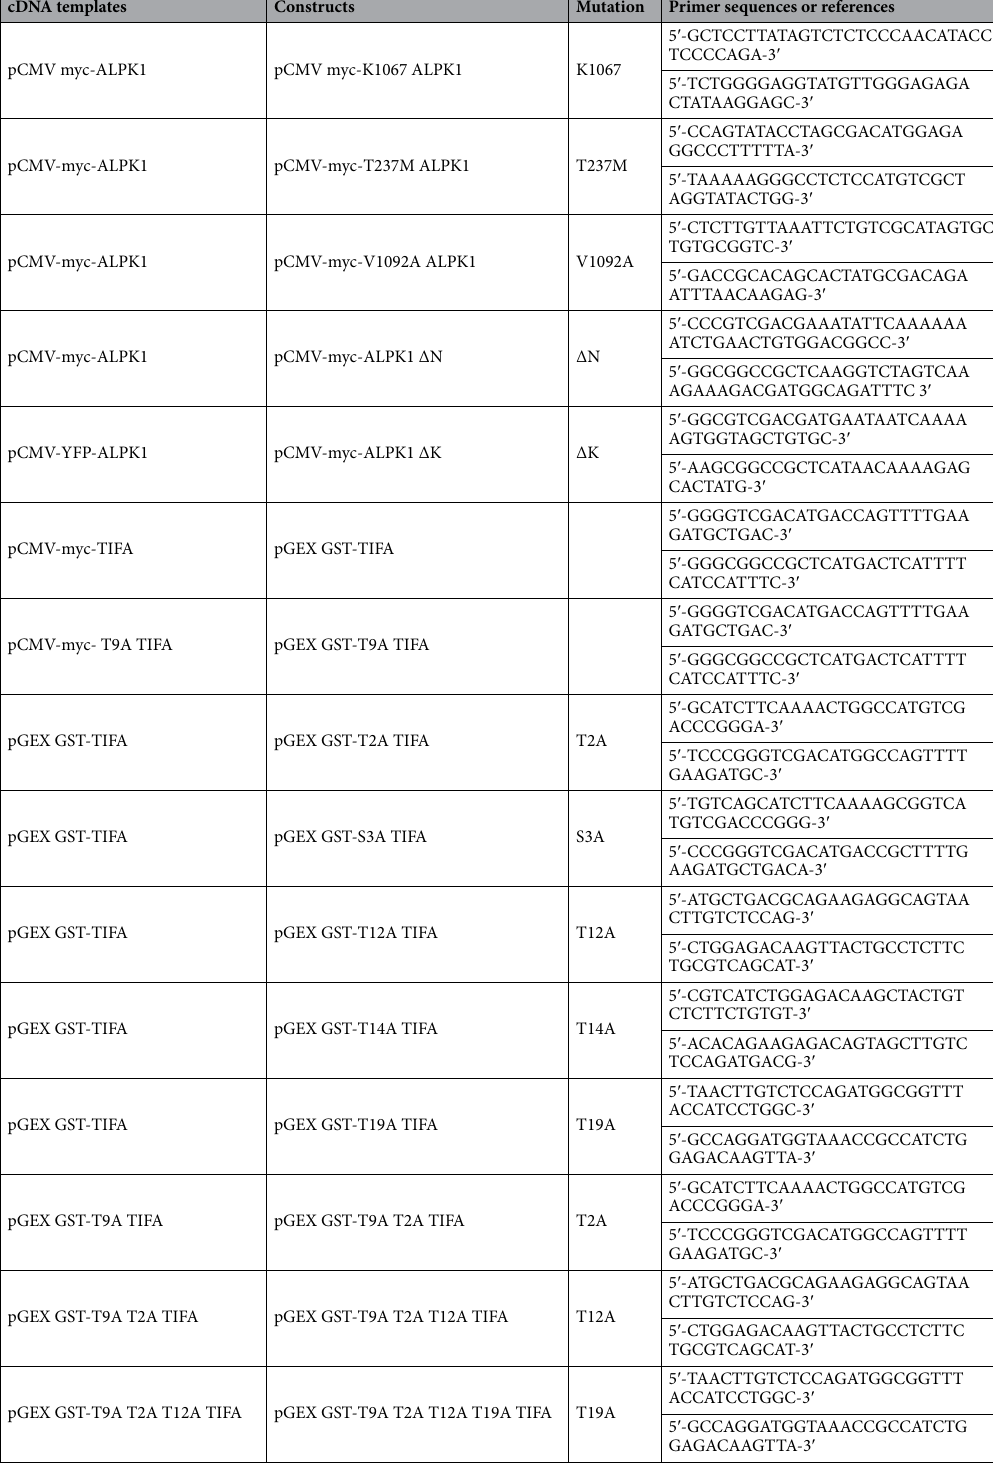
Table 1. List of primers used to generate the ALPK1 and TIFA